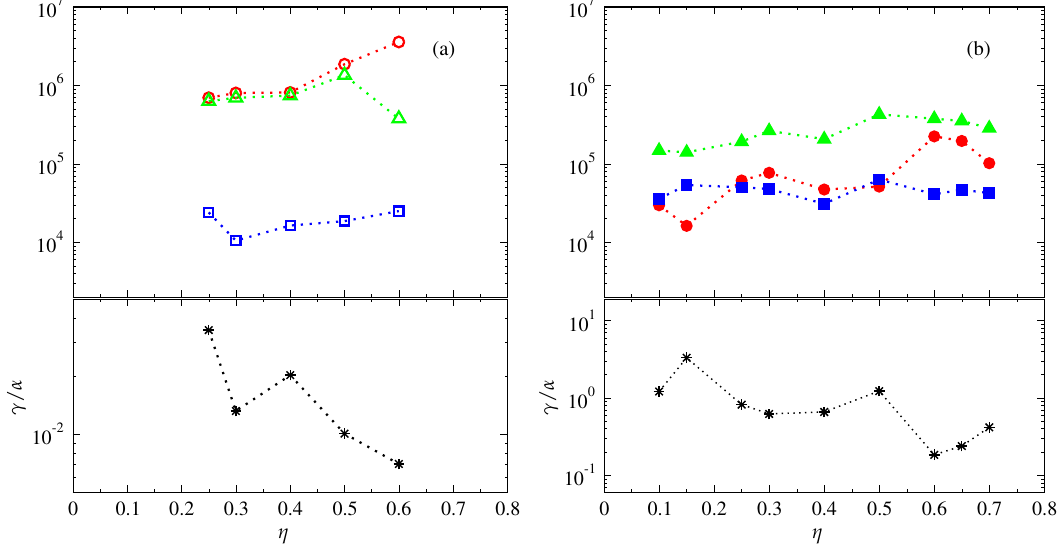
Figure 10. Magnitude of α -, β -, and γ -effects with increasing shell thickness aspect ratio η for dynamo solutions with R = 3.8 10 4 , P = 0.75 and P m = 1.5. The upper panels show root-mean R c , τ = 2 × × squared time-averaged values of the α -effect (red circles), β -effect (green triangles up) and γ -effect (blue squares). The lower panels show the ratio of γ -to α -effects. Column ( a ) contains MD dynamo solutions (empty symbols) while column ( b ) contains FD dynamo solutions (full symbols) as shown in Figure 8. (Colour